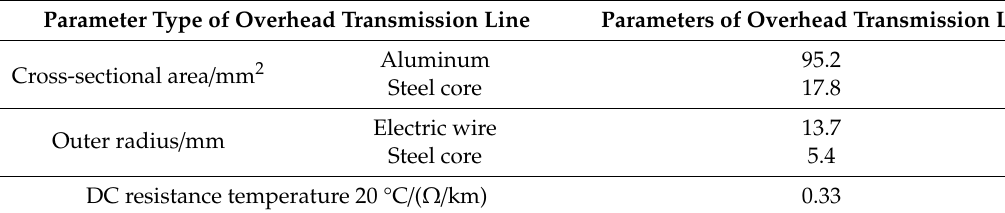
Table 2. Parameters of transmission lines.